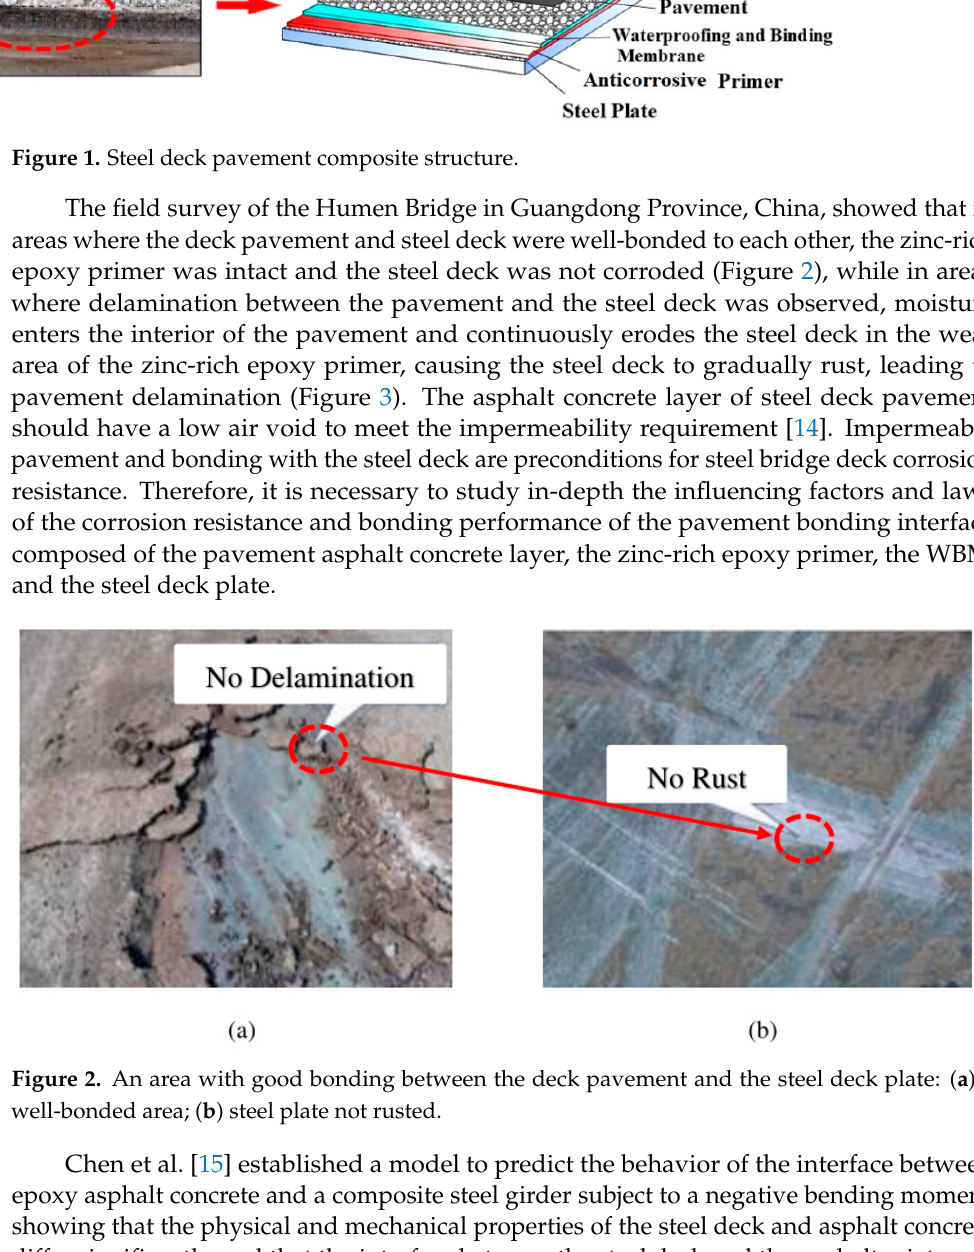
Figure 3. An area with delamination between the deck pavement and the steel deck plate: ( a ) a delaminated area; ( b ) steel plate rusted.